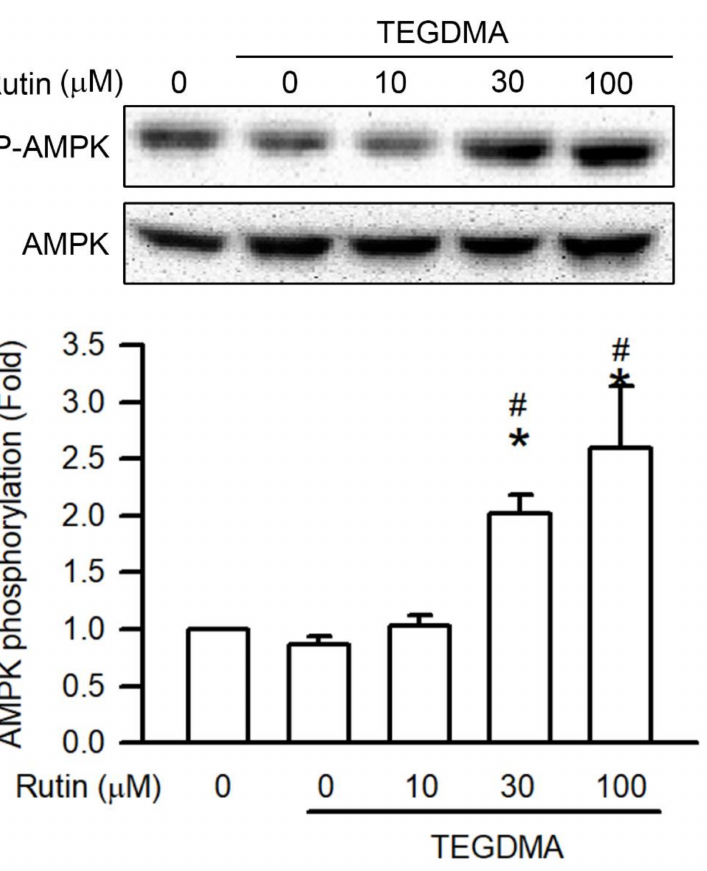
Figure 8. Effect of rutin on AMPK phosphorylation in TEGDMA-treated RAW264.7 macrophages. Phosphorylation of AMPK was determined using Western blotting with indicated antibodies. Repre- sentative blots and quantitative results are shown. Values are expressed as mean ± S.D. of three times per group. * Represents significant difference between the indicated and control groups, p < 0.05. # Means significant difference between the indicated and TEGDMA groups, p <